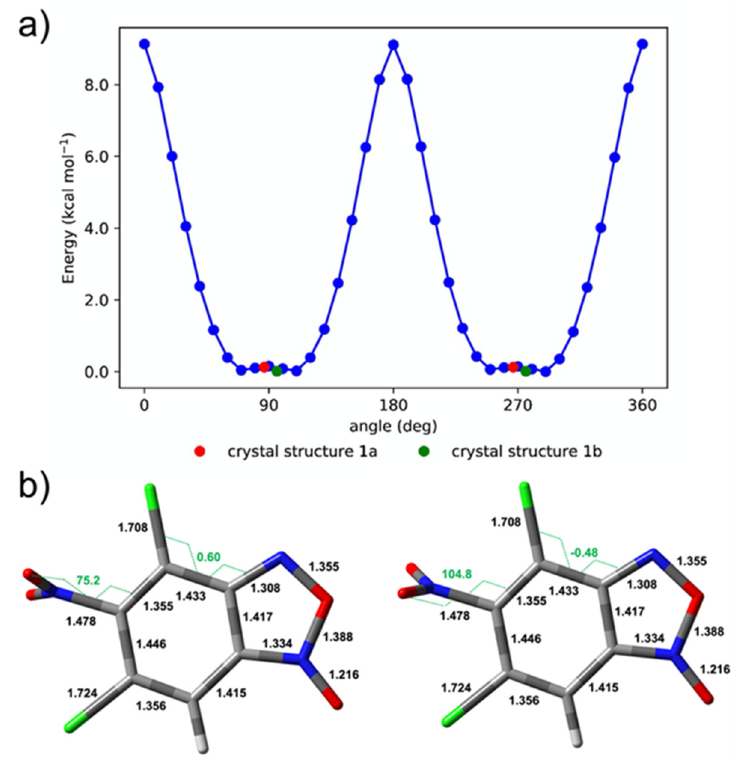
Figure 12. ( a ) Rotational barrier of the nitro group in the 4,6-dichloro-5-nitrobenzofuroxan molecule ( 1 ) in solution. ( b ) Optimized structures of ( 1 ) in solution. ( 1 ) in solution. ( b ) Optimized structures of ( 1 ) in